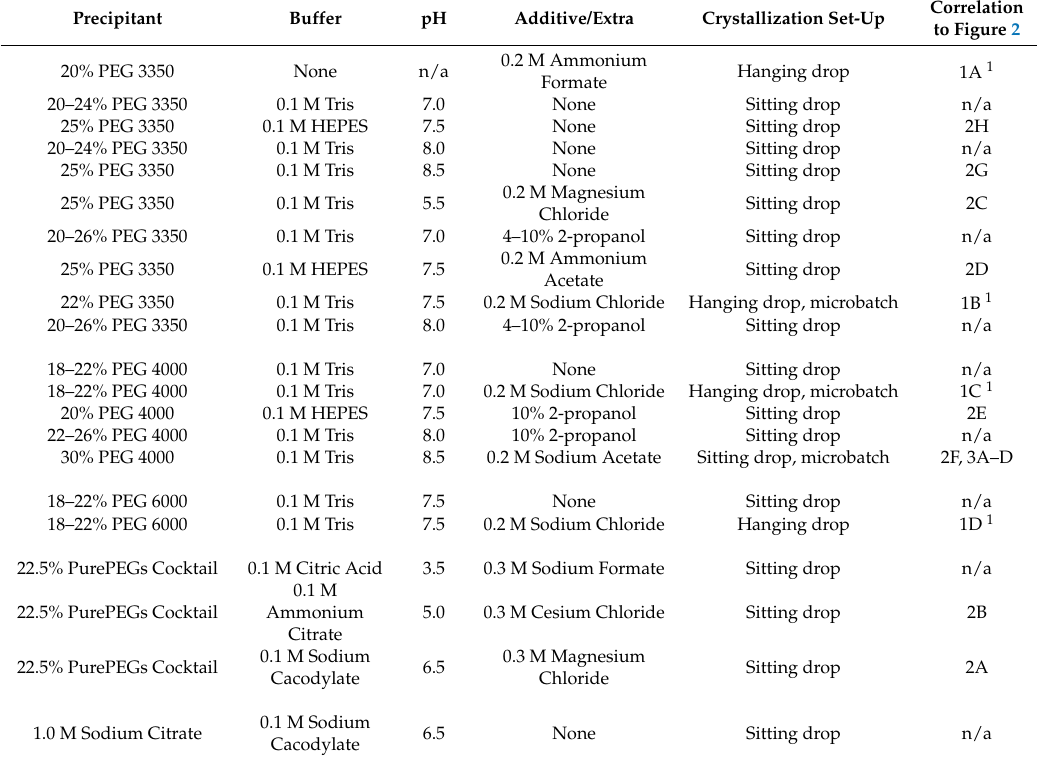
Table 1. Summary of crystallization conditions that yielded crystals.